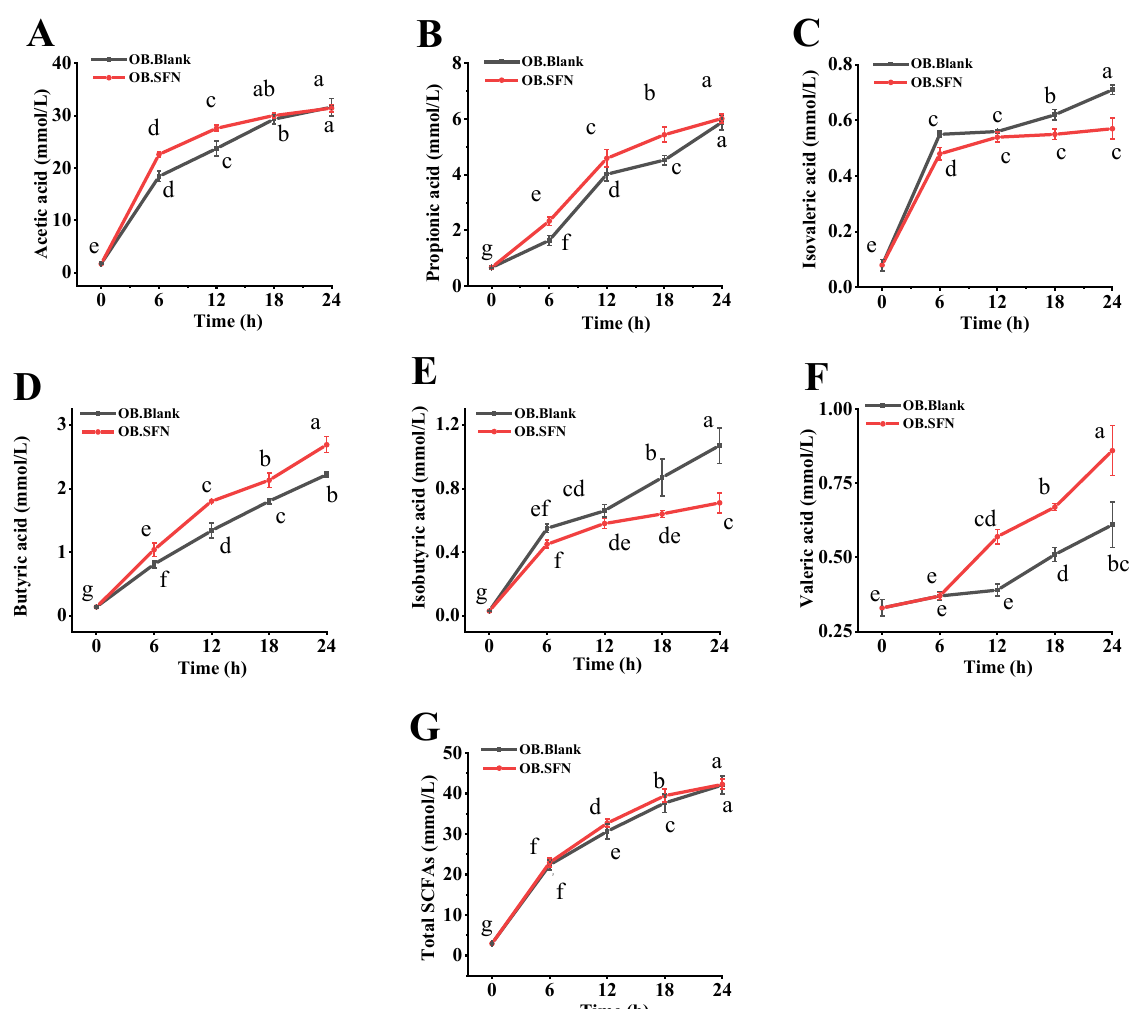
Figure 4. Sulforaphane (SFN) affects the metabolites produced by gut microbiota during fermentation. Concentrations of ( A ) acetic acid, ( B ) propionic acid, ( C ) isobutyric acid, ( D ) butyric acid, ( E ) isovaleric acid, ( F ) valeric acid and ( G ) total short-chain fatty acids (SCFAs). a–g: Different letters indicated significant differences in the same group using Tukey test ( p <